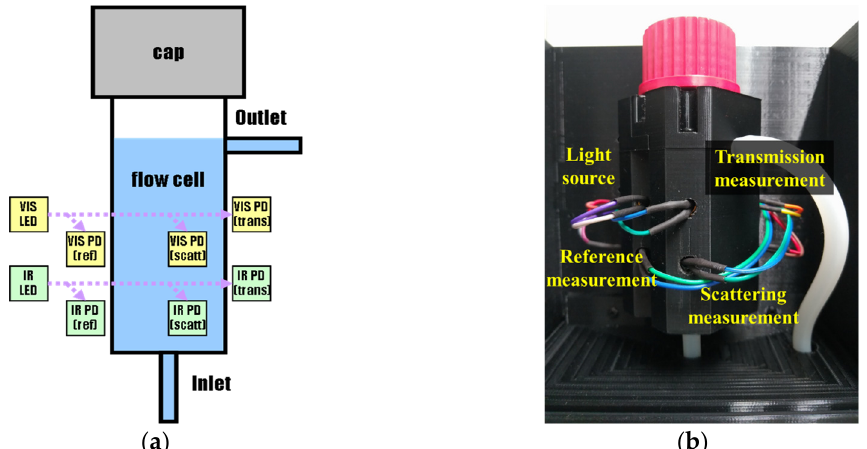
Figure 6. Turbidity sensing module ( a ) Design graph. ( b ) Optical module.